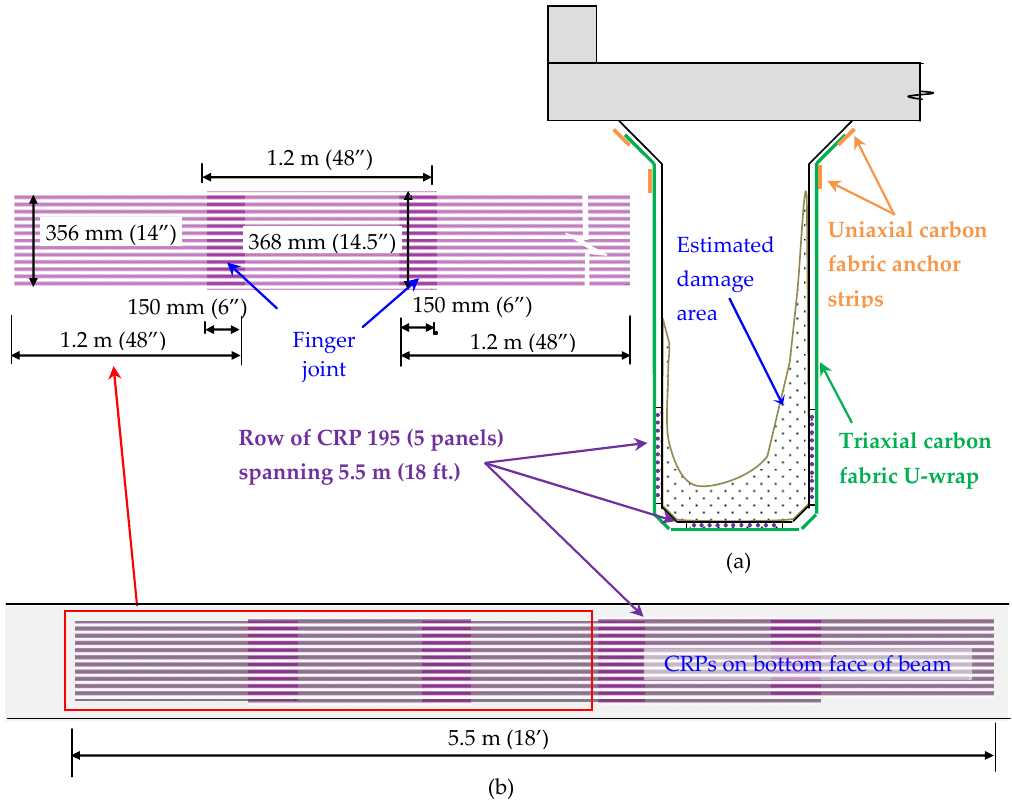
Figure 6. CRP retrofit design ( a ) Section of RC girder; ( b ) Bottom surface view of CRP on girder.